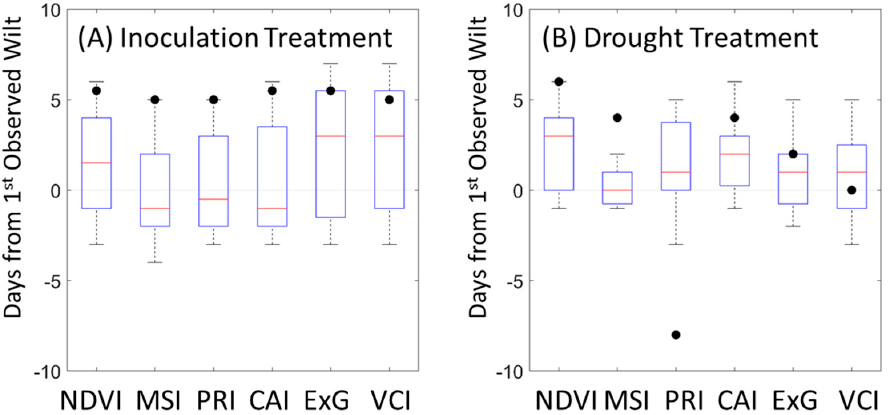
Figure 10. Boxplots of stress onset detection dates for the different VIs, relative to first observed wilt (time zero). (A) Inoculated treatment on left, (B) drought treatment on right. Negative values indicate the detection of stress prior to first recorded observation of wilt. Black dots represent the median date (relative to first observed wilt) each VI curve passed a 20% threshold value.